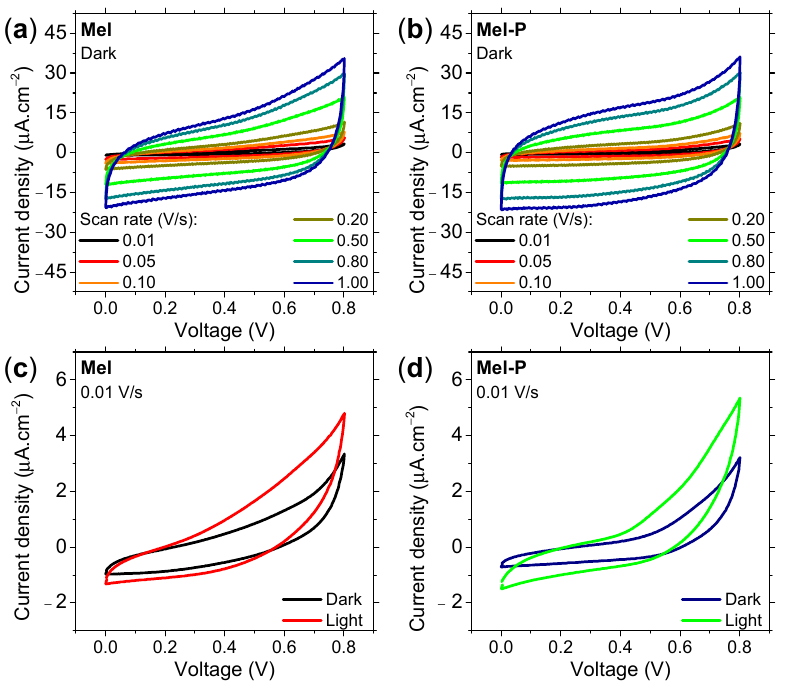
Figure 3. ( a ) Mel and ( b ) Mel-P cyclic voltammogram spectra at different scan rates. ( c , d ) Comparison